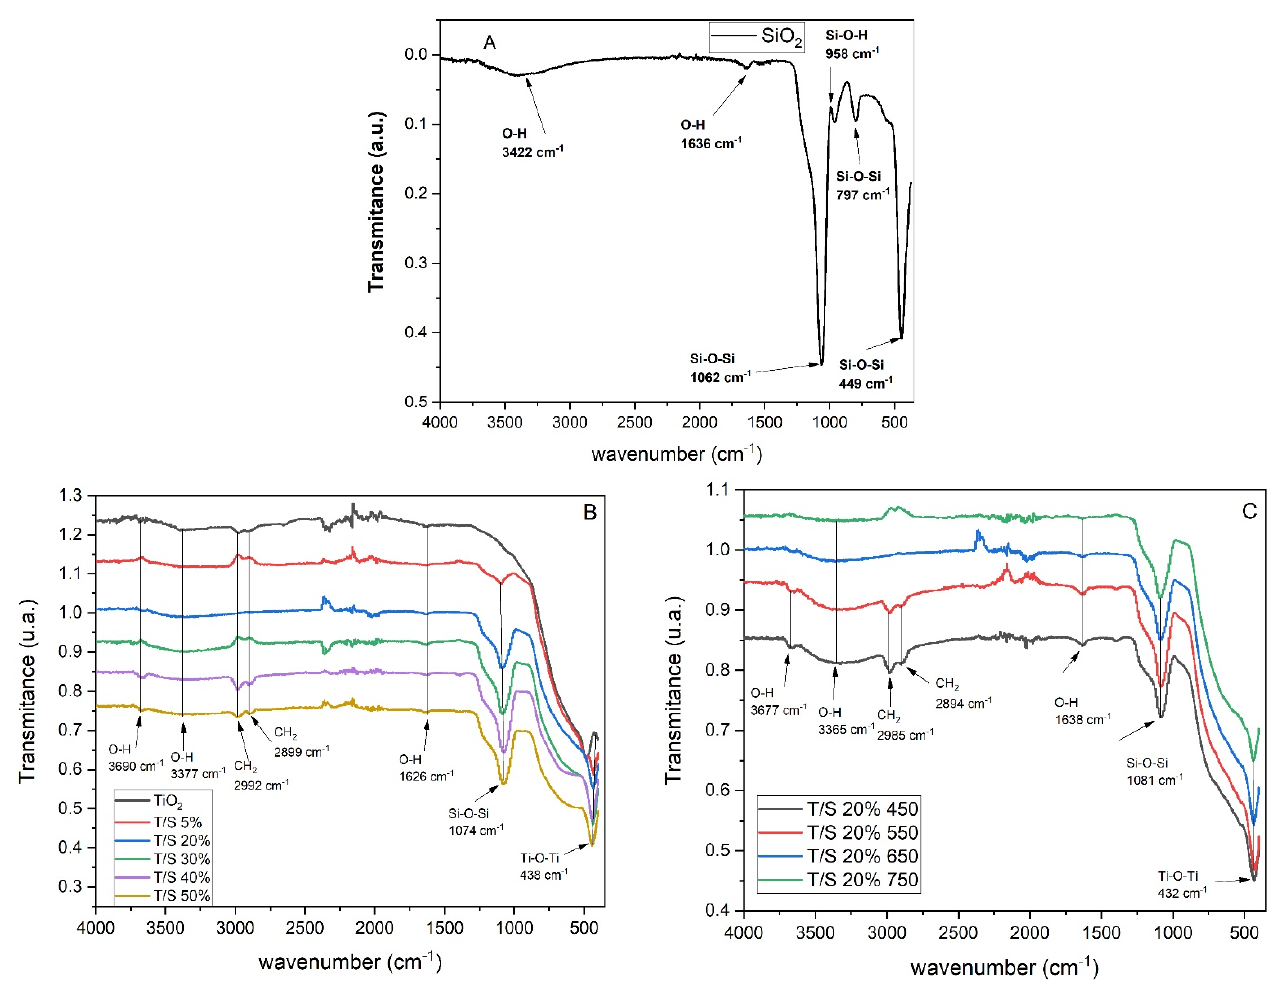
Figure 6. IR spectrum of ( A ) silica, the composites ( B ) T/S–X; ( C ) T/S–20%–T.